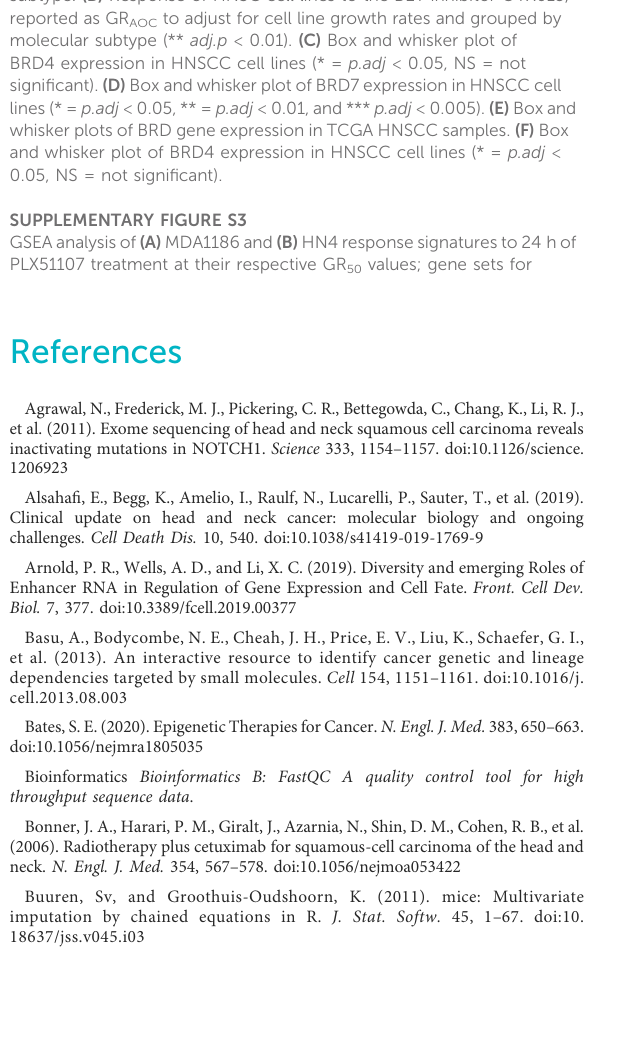
SUPPLEMENTARY TABLE S4 PRO-seq quality metrics for each HNSCC cell line sample as reported by the PEPPRO